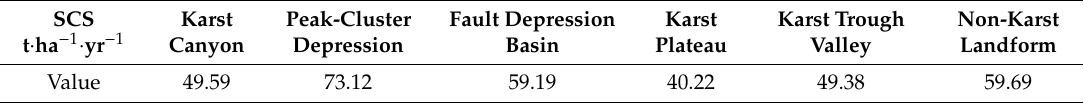
Table 3. Average SCS in di ff erent landform regions on the Guizhou